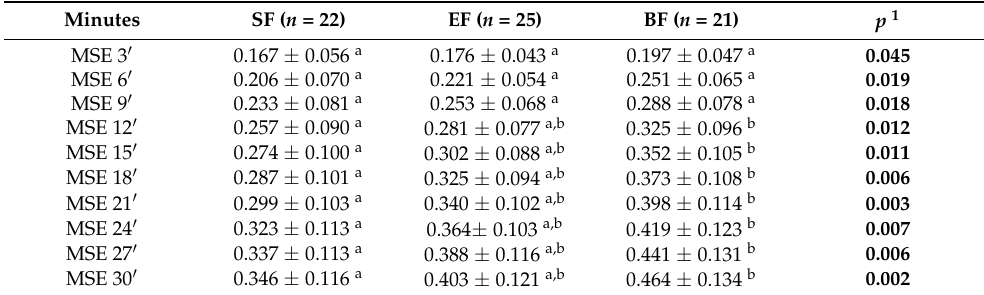
Table 6. MSE analysis by study group in six-year-old normoweight (NW) children, calculated using the Slaughter’s